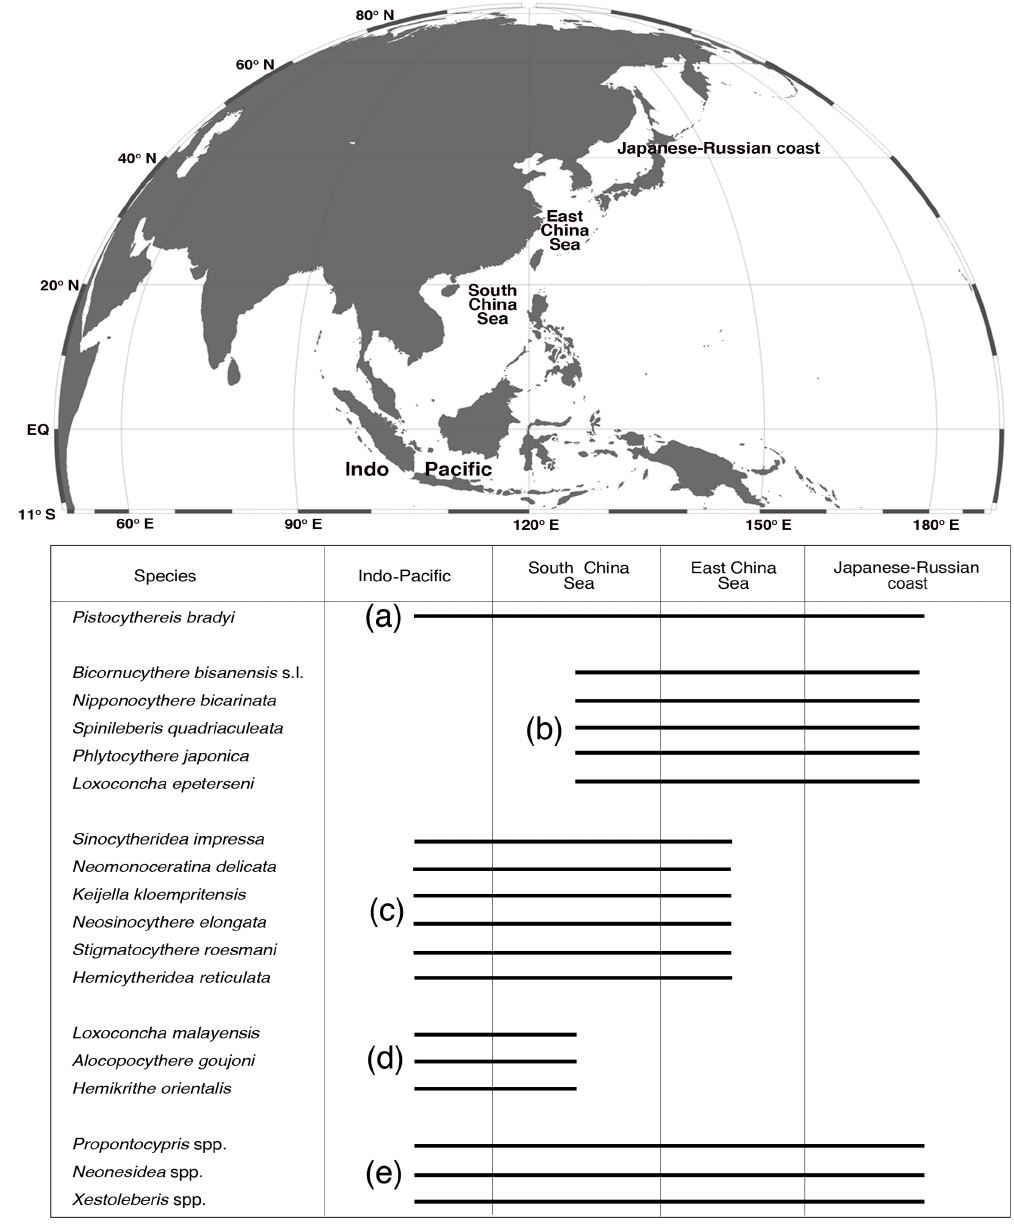
Figure 4. Geographical distributions of the 18 taxa in the northwestern Pacific and Indo-Pacific regions, including Pistocythereis bradyi , Bicornucythere bisanensis s.l., Nipponocythere bicarinata , Spinileberis quadriaculeata , Phlyctocythere japonica , Loxoconcha epeterseni , Sinocytheridea impressa , Neomonoceratina delicata , Keijella kloempritensis , Neosinocythere elongata , Stigmatocythere roesmani , Hemi- cytheridea reticulata Loxoconcha malayensis , Alocopocythere goujoni , Hemikrithe orientalis , Propontocypris spp., Neonesidea spp., and Xestoleberis spp. (a) Widespread group; (b) temperate group; (c) subtropical group; (d) tropical group; and (e) globally distributed group. The following references were used mainly to determine the geographical distributions of the species: Al Jumaily and Al-Sheikhly (1999); Dewi (1997); Dong et al. (2012); Fauzielly et al. (2013); Gu et al. (2017); Hong et al. (2017); Hou and Gou (2007); Hussain et al. (2004, 2010); Hussain and Mohan (2000, 2001); Irizuki et al. (2006, 2009); Iwatani et al. (2014); Liu et al. (2013); Li (1985); Mostafawi (1992); Nishath et al. (2017); Noraswana et al. (2014); Pugliese et al. (2006); Schornikov et al. (2014); Tanaka et al. (2009, 2011); Wang et al. (1988); Wang and Zhang (1987); Wang and Zhao (1985); Zhao (1984); Zhao and Wang (1988a, b, 1990); Zhao and Whatley (1993); Zhou et al. (2015). Note that Sinocytheridea impressa is known to be distributed in Japan, but their Japanese distribution is very limited in certain areas of the southern part of Japan (Iwasaki, 1992; Tanaka et al., 2019). Thus, we did not indicate their Japanese–Russian coast distribution in this